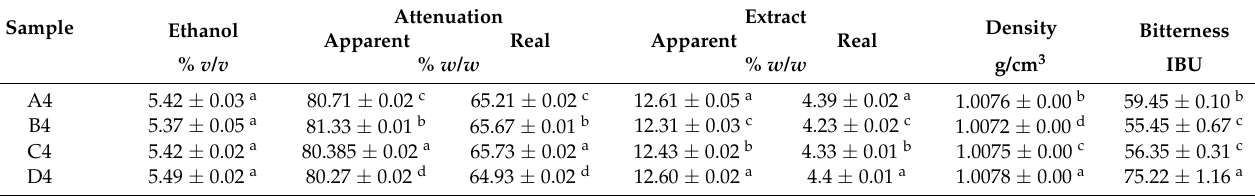
Table 1. Physicochemical properties of